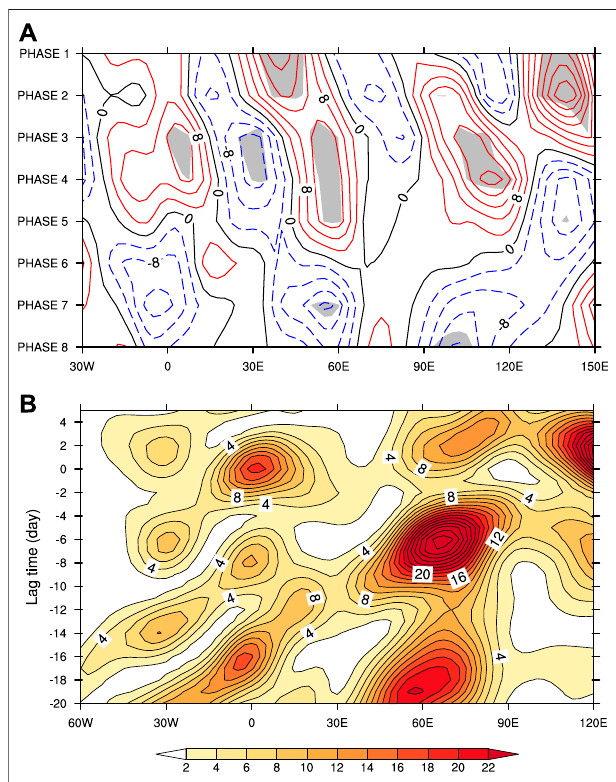
FIGURE7 |(A) Phase-longitude cross section of 10 – 30 days fi ltered PV (unit: 10 – 8 K s − 1 kg − 1 ) at 200 hPa along 45 ° – 65 ° N. (B) Time-longitude cross section of vertically integrated 10 – 30 days fi ltered kinetic energy (KE) regressed onto the WPSH_SMI_10-30d along 45 ° – 65 ° N (unit: m − 2 s − 2 ). Positive (negative) lagged time denotes that 10 – 30 days fi ltered KE lags (leads) WPSH_SMI_10-30d . For example, “ − 10 ” means that 10 – 30 days fi ltered KE leads WPSH_SMI_10-30d by 10 days.